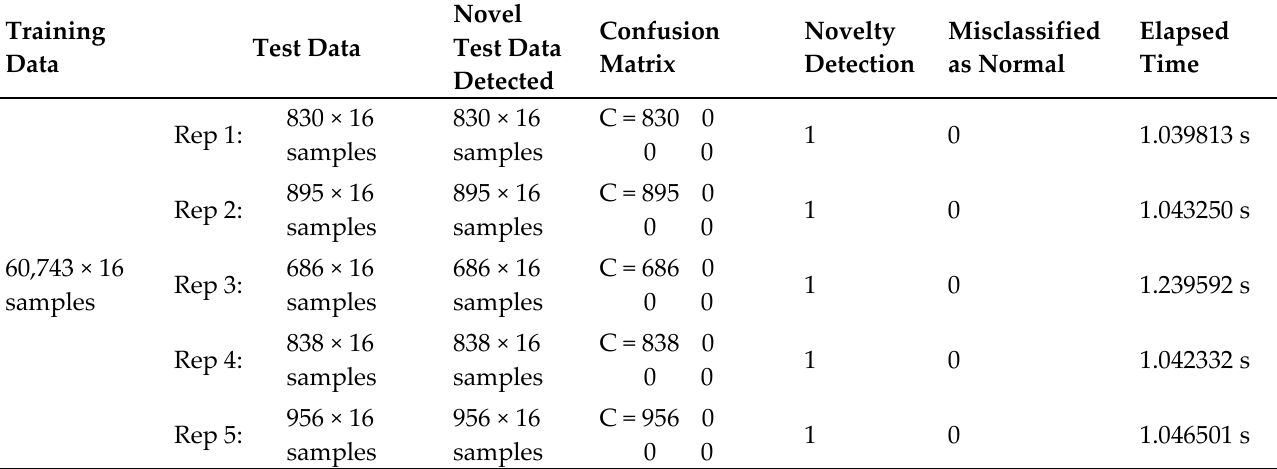
Table 5. Mahalanobis algorithm.